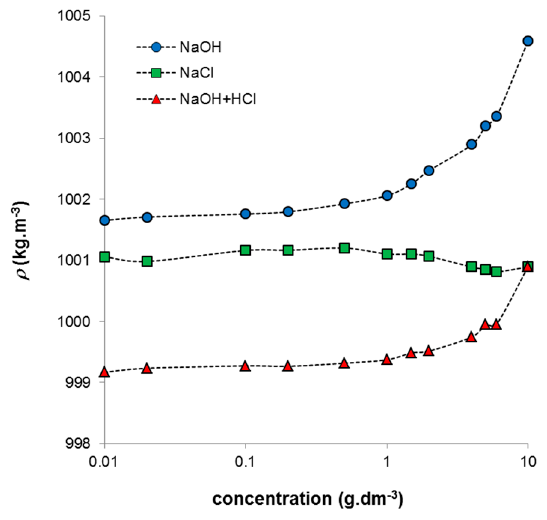
Figure 2. Obtained density of prepared humic sols in dependence on concentration of humic acids.